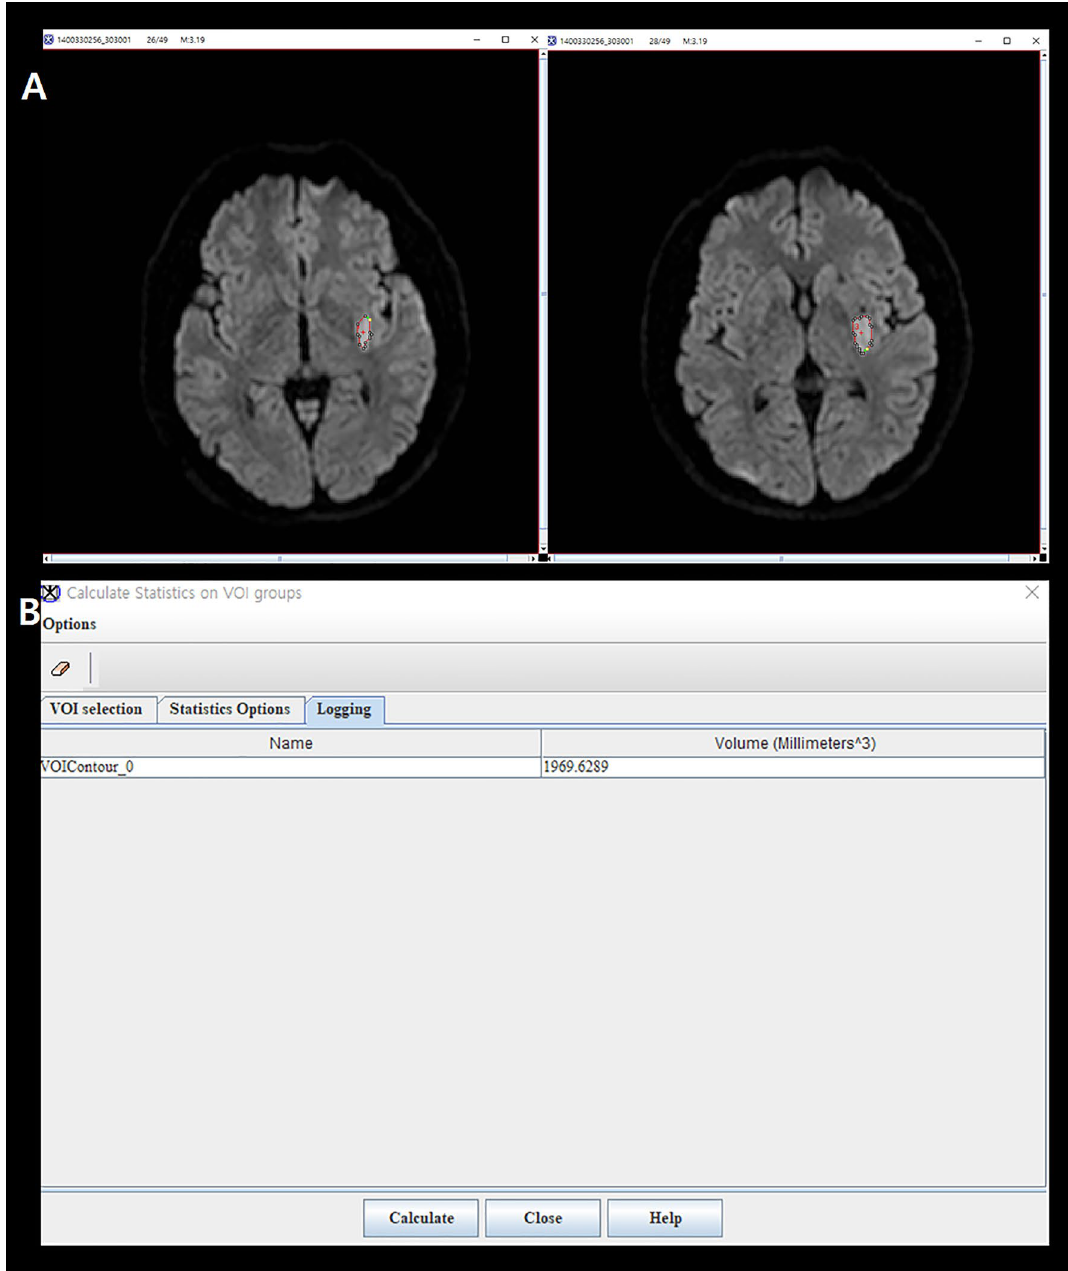
Figure 3. A representative example of how to calculate the infarct growth velocity. We quantitatively measured initial infarct volume using MIPAV version 11.0.0. program. The infarct lesions of each slice were delineated in a semi-automated way. After that, the program automatically calculated the volume by summing the lesion area of each slice. The initial infarct volume measured in this way was 1.97 mL, and MRI was conducted in this patient 1 h after symptom onset. Therefore, according to the formula, it is calculated that this patient had an IGV value of 1.97